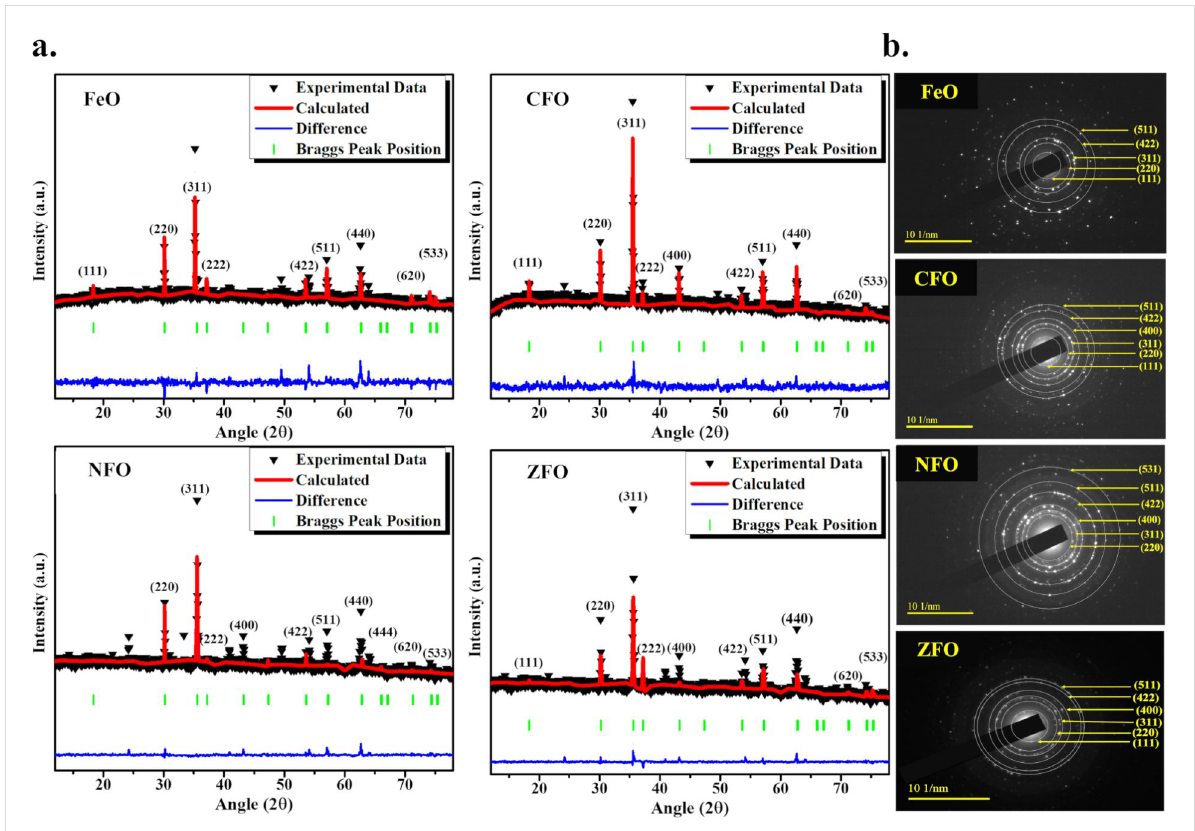
Figure 1: (a) Rietveld-refined XRD pattern of MFe 2 O 4 (M = Fe, Co, Ni, Zn) NPs with SAED images showing different hkl planes. The triangles repre- sent experimental points and the solid red line represents Rietveld-refined data. The bottom line (blue) shows the difference between the experimen- tal and refined data. (b) The marked 2 θ positions are the allowed Bragg peaks.